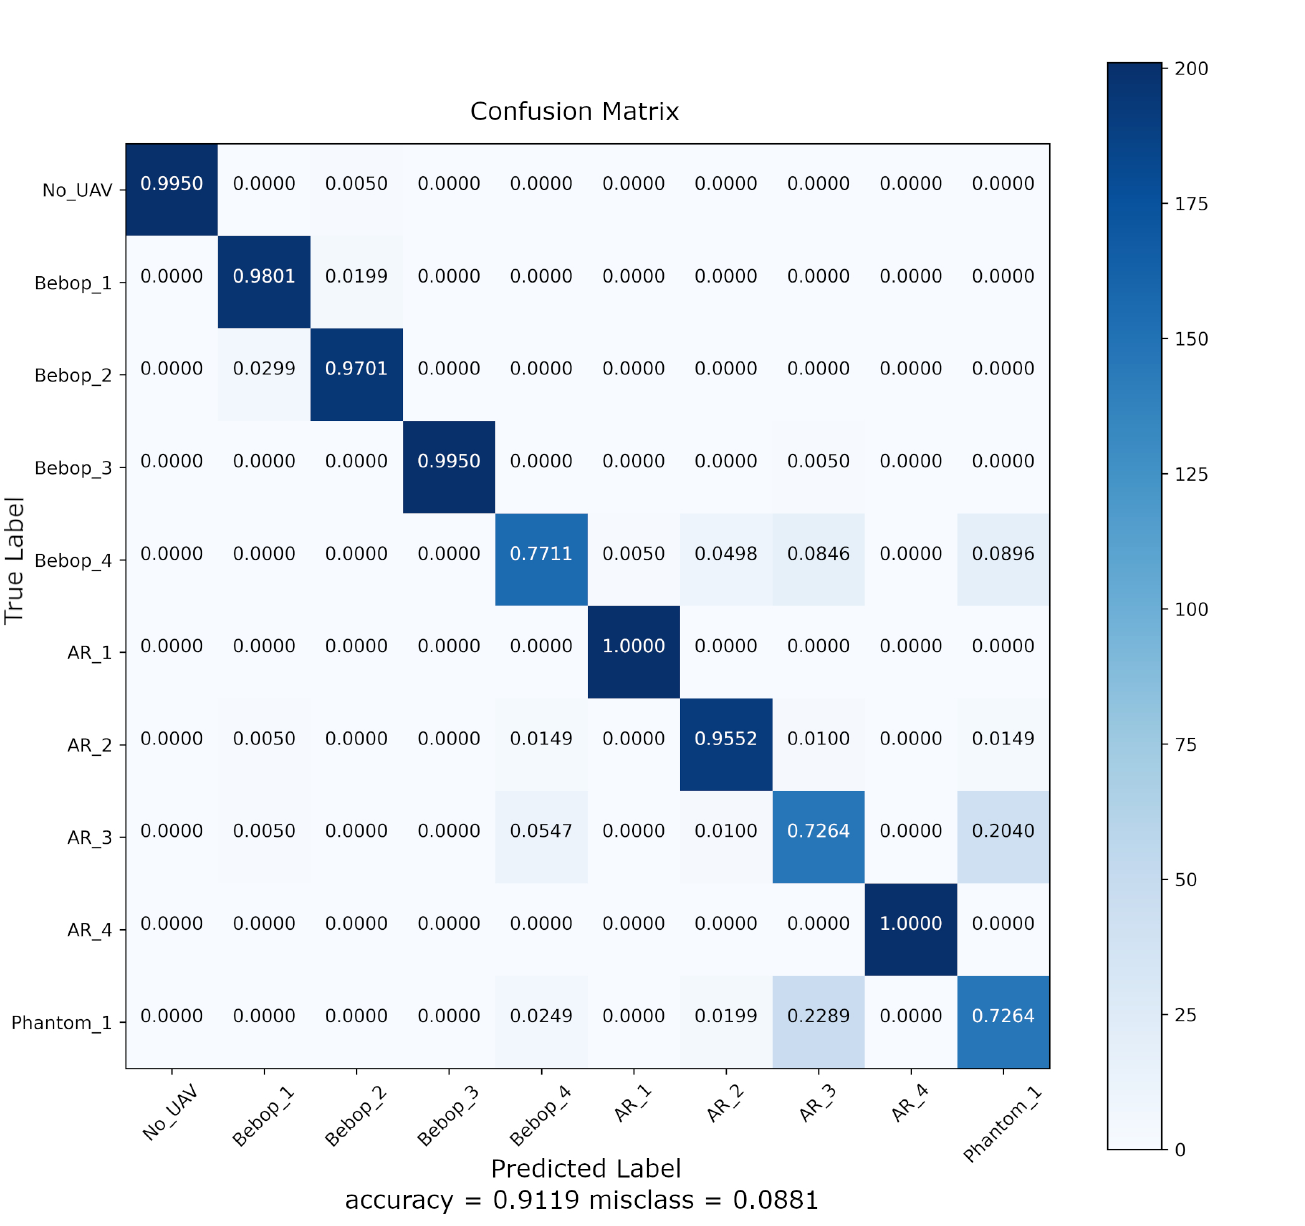
Figure 18. Confusion Matrix